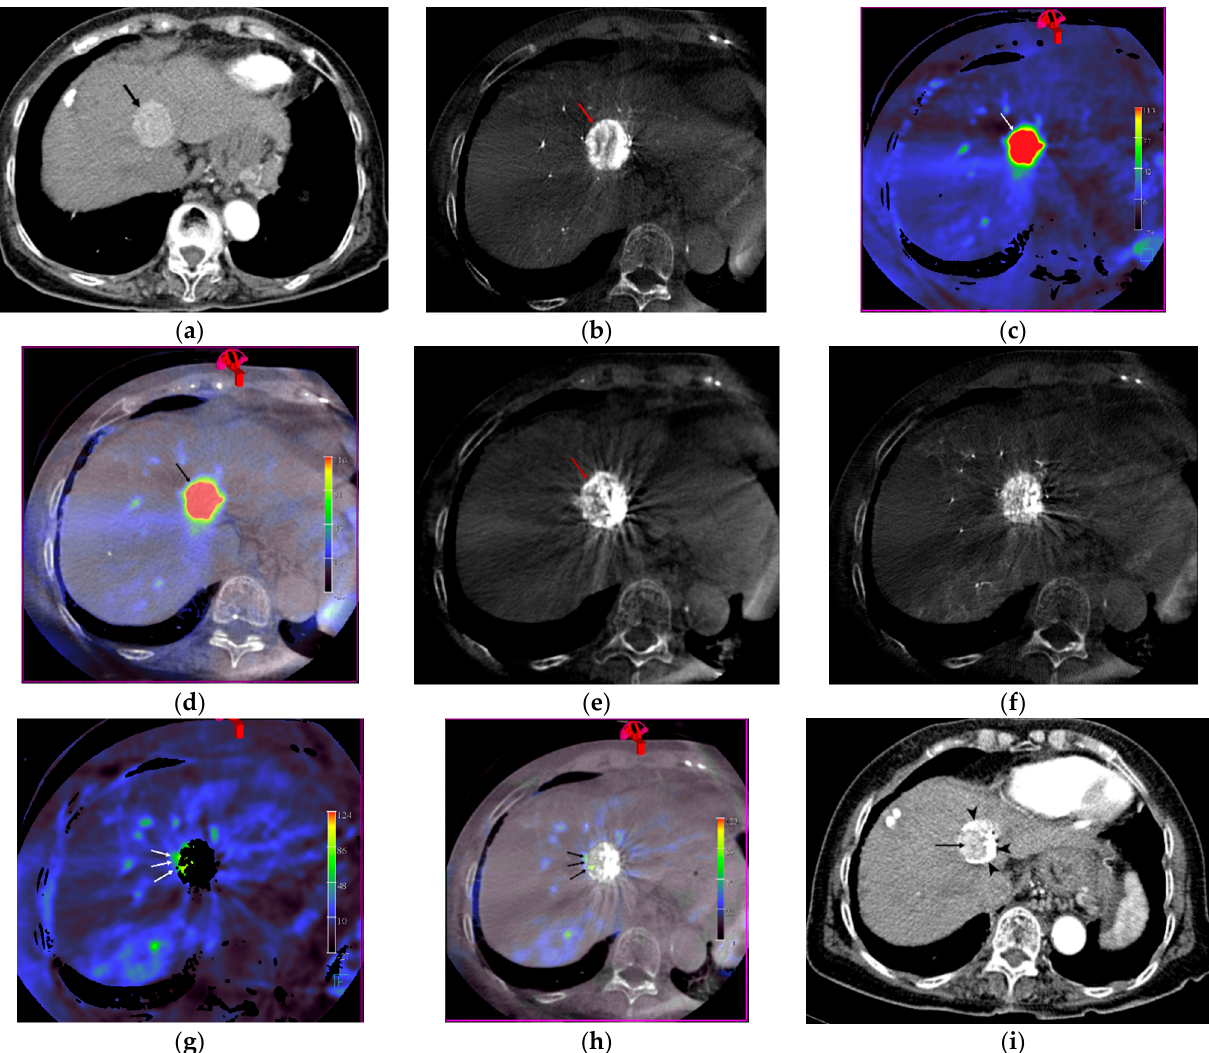
Figure 2. A 72-year-old woman with advanced liver cirrhosis and hepatocellular carcinoma (HCC) in segment 4 of the liver. She underwent transarterial chemoembolization. ( a ) An approximately 3.0 × 2.6-cm enhancing mass (arrow) is noted in segment 4 of the liver in the arterial phase of contrast-enhanced dynamic computed tomography (CT) of the liver. ( b ) A contrast-enhancing mass (arrow) is demonstrated on enhanced cone-beam CT. ( c , d ) The mass (arrow in c , d ) shows increased perfusion, seen in red, on cone-beam CT-based perfusion-mapping; pure perfusion imaging ( c ) and fusion image of perfusion image and pre-transarterial chemoembolization (TACE) unenhanced CBCT image ( d ). ( e ) Compact ethiodized oil deposition is noted at the previously noted viable tumor (arrow) on unenhanced cone-beam CT performing after chemoembolization. ( f ) A viable tumor is not clearly observed on enhanced cone-beam CT performing after chemoembolization. ( g , h ) A focal, nodular, increased perfusion area, seen in yellow and light green color (arrow in g , h ), suspicious for residual tumor, is demonstrated at the medial aspect of the mass by ethiodized oil deposition on cone-beam CT-based liver-perfusion-mapping performed after chemoembolization; pure perfusion imaging ( g ) and fusion image of perfusion image and post-TACE unenhanced cone beam computed tomography (CBCT) image ( h ). ( i ) CT image obtained 3 months after transarterial chemoembolization shows an enhancing portion (arrow) at the medial aspect of the treated HCC with ethiodized oil deposition (arrowhead). This enhancing portion (arrow) was presumed to be a viable tumor portion.